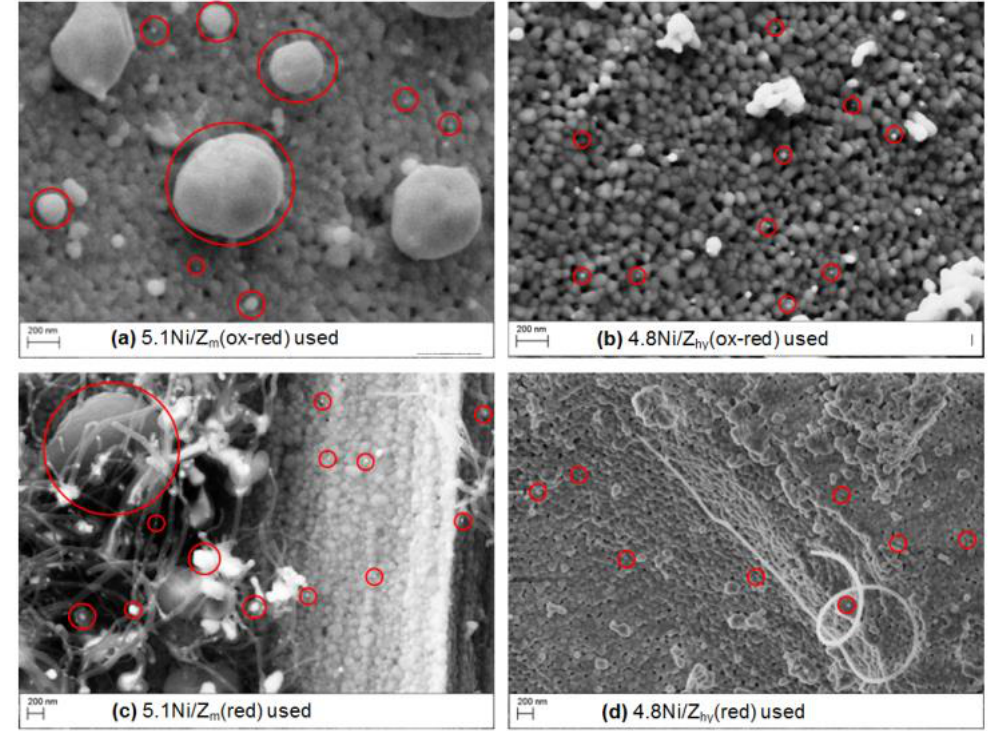
Figure 8. ( a – d ) FESEM images of 4.8Ni/Z hy and 5.1Ni/Z m used catalysts. Red circles highlight some Ni particles. Raman spectroscopy, in agreement with FESEM results, clearly identified carbona- ceous deposits on both 5.1Ni/Z m ( red ) and 4.8Ni/Z hy ( red ) used catalysts. As illustrated in Figure 9 for the 5.1Ni/Z m ( red ) used sample as an example, in addition to the bands due to monoclinic ZrO 2 , bands at about 1320 cm −1 (D band) and 1584 cm −1 (G band) were rec- orded. The G band (‘graphite peak,’ E 2g symmetry) is characteristic of a perfect graphite lattice, whereas the D band (‘defect peak,’ A 1g symmetry) is related to a defective gra- phitic lattice [53]. The nonoverlapping of the D and G bands is consistent with the pres- ence of a structured carbon; the band at about 1584 cm −1 could originate from graphitic carbon types on the catalyst’s surface and that at about 1320 cm −1 could originate from carbon nanoparticles or defective filamentous carbon. The relative intensity of the D band to the G band, I D /I G , has been taken as a measure of the structural disorder of the carbon material, a high ratio indicating a large amount of disorder in the structure and more reactive carbon species [24]. An I D /I G value of 0.9 was obtained by the curve fitting pro- cedure for the 5.1Ni/Z m ( red ) used sample, indicating the presence of a significant con- tribution of graphite-type structures.